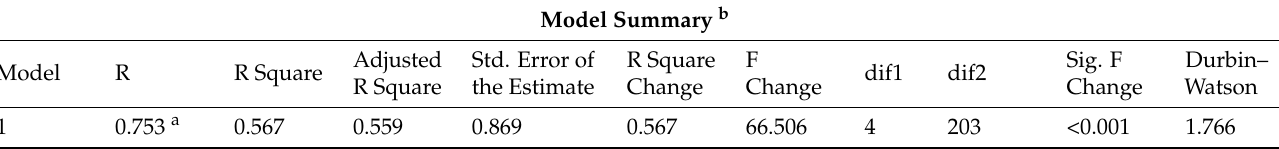
Table 6. Model summary.